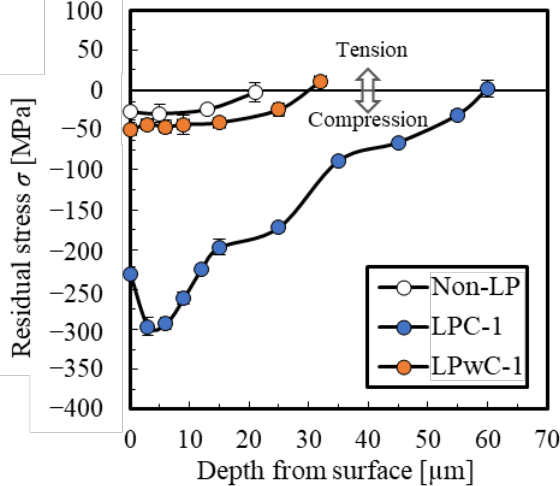
Figure 9. Residual stress distribution of each